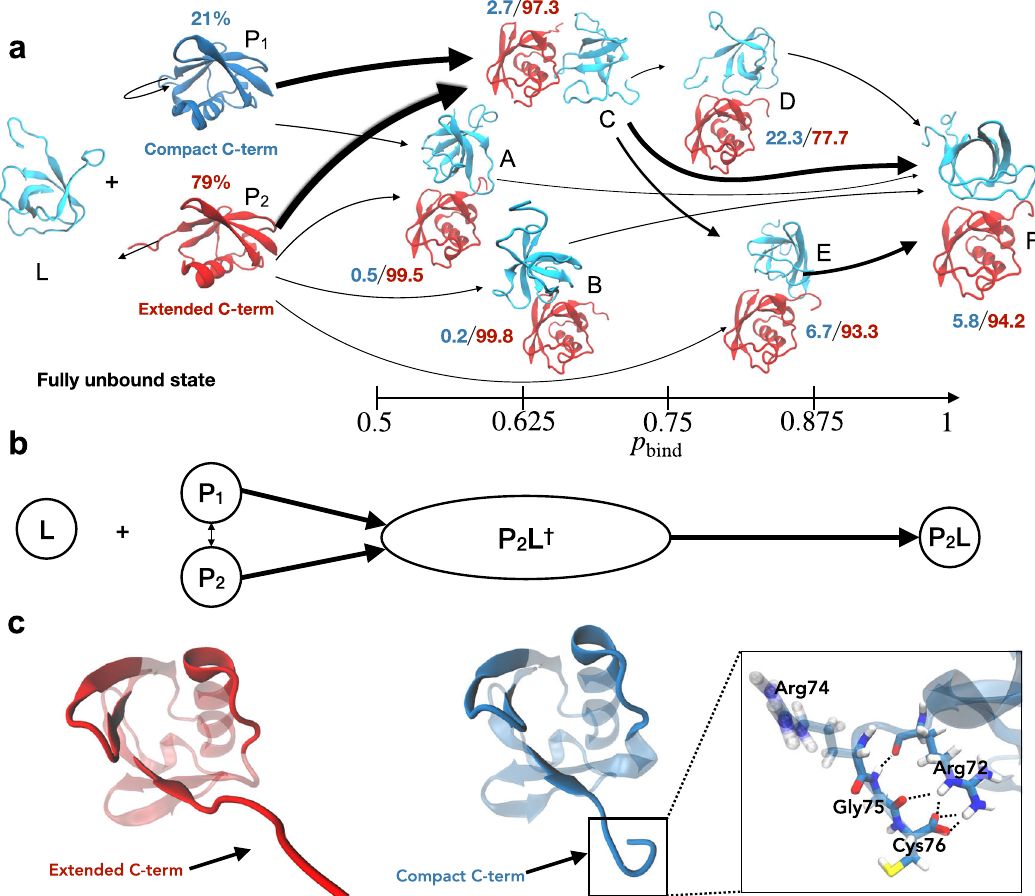
Fig. 3 Ubiquitin-SH3c binding mechanism in the Markov state model. a Reactive fl ux along the dominant binding pathways, minor fl ux states are omitted from visual representation for clarity. The magnitude of the fl ux along different binding pathways is represented qualitatively by the width of the arrows that interconnect the states. Ubiquitin is shown in red in Markov states in which it predominantly adopts the extended C-terminal conformation P 2 . In the unbound state with compact C-terminal conformation P 1 , ubiquitin is shown in blue. SH3c as ligand L is shown in cyan. The relative probabilities of the compact and extended C-terminal conformation in the different states are indicated in blue and red. The probabilities p bind of the Markov states for reaching the native bound state prior to the fully unbound state are given at the bottom. b Coarse view of the binding mechanism with the unbound ubiquitin states P 1 and P 2 and the binding transition state P 2 L † and bound state P 2 L in which ubiquitin predominantly adopts the conformation P 2 with extended C-terminus. The binding transition state P 2 L † includes all Markov states with intermediate binding probabilities 0.45 < p bind < 0.75. c Representative ubiquitin structures with extended and compact C-terminus. Interactions that stabilize the compact C-terminal conformation are illustrated at the